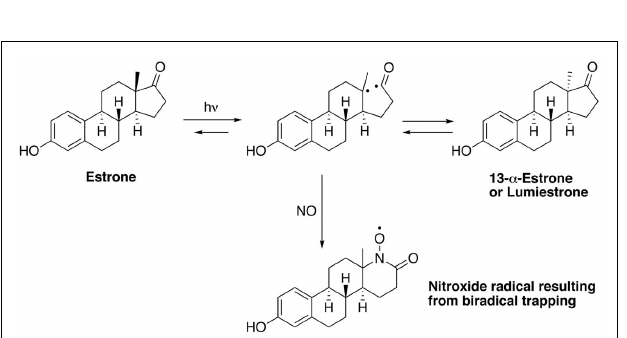
FIGURE 2 | Proposed mechanism for the phototransformation of estrone into lumiestrone.